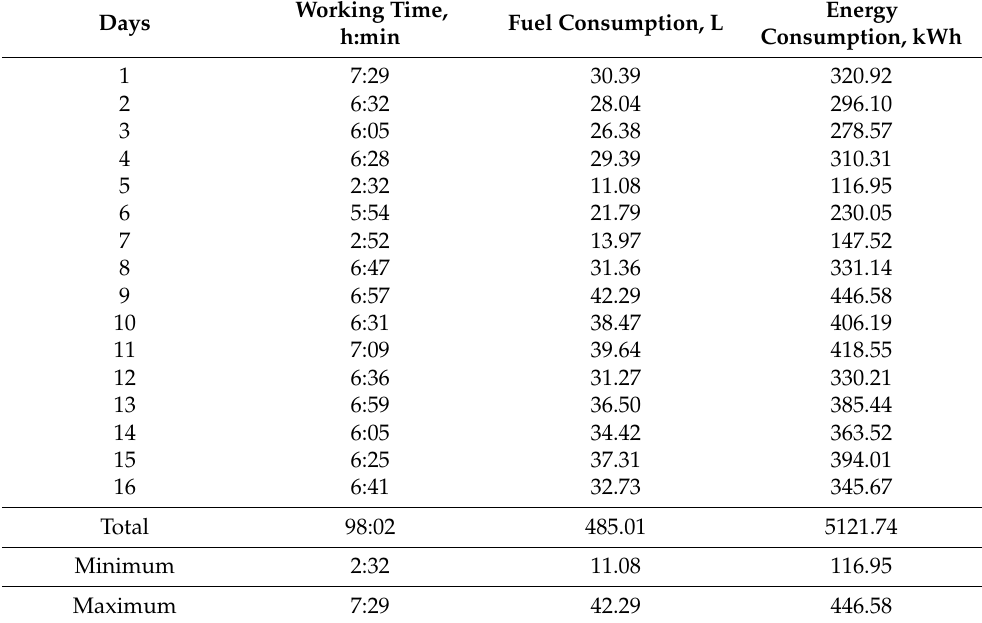
Table 3. Skidder energy consumption per